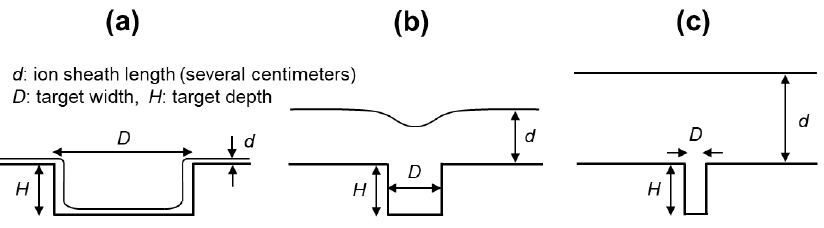
Figure 2. Plasma molding over a trench target with various width D and depth H. (a) when D > d model, (b) when D ≈ d model, and (c) when D < d model. (Ion sheath length d is expected to be several centimeters under the experimental conditions of this study [14]).